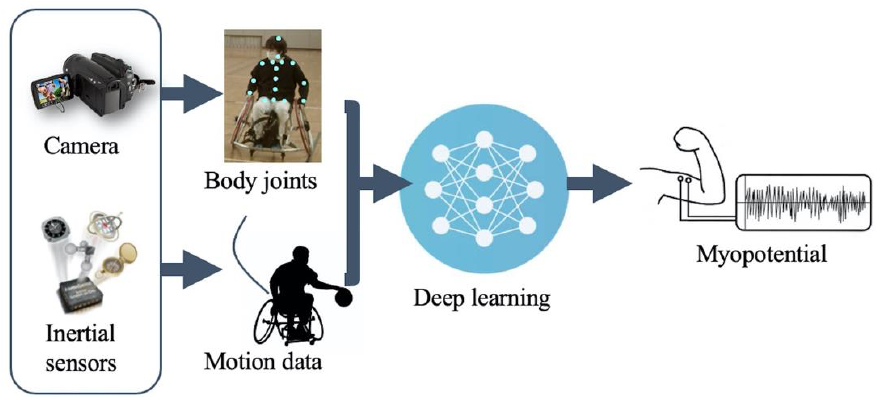
Figure 1. Outline of the proposed method.